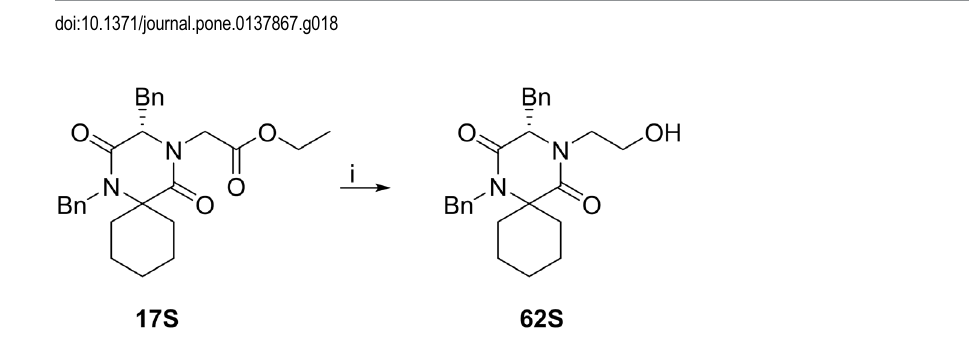
doi:10.1371/journal.pone.0137867.g018